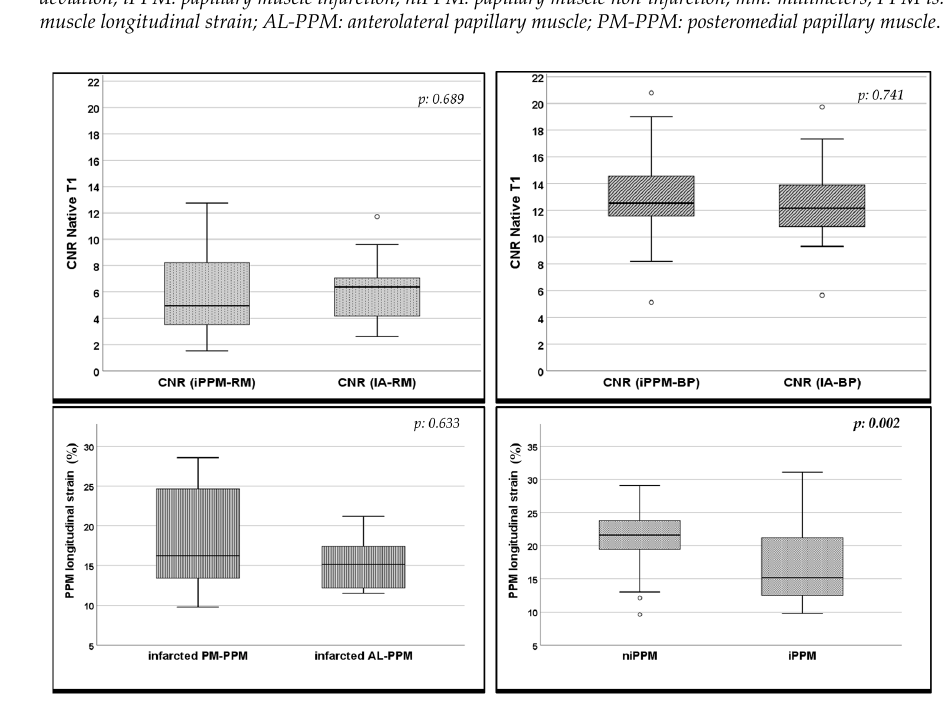
Figure 4. Box plot graphs. The upper row shows the CNR value comparison between CNR (infarcted PPM/RM) and CNR(IA/RM) on the left, and CNR(IA/BP) vs. CNR (infarcted PPM/BP) on the right. The row below shows the PPM-ls comparison between the infarcted AL- vs. PM-PPM and between the infarcted vs. non-infarcted PPMs. Error bars represent the 95% CI, and the top and the bottom of the boxes represent the third and the first quartiles, respectively. p -values are calculated with the Student-T test and considered to be significant when <0.05. CNR: contrast-to-noise ratio; PPM: papillary muscle; IA: infarcted area; RM: remote myocardium; BP: blood pool; AL-PPM: anterolateral papillary muscle; PM-PPM: posteromedial papillary muscle. All of the CNR values calculated in the T1 maps are reported in Table 4. The compar- isons between the CNR of the infarcted-PPM and the IA did not show any significant difference for both the/BP and/RM CNRs ( p : 0.741 and 0.689, respectively), as shown in Figure 4. Table 4. The CNR values of infarcted-PPM to BP/RM and of IA to BP/RM calculated in the T1 maps.